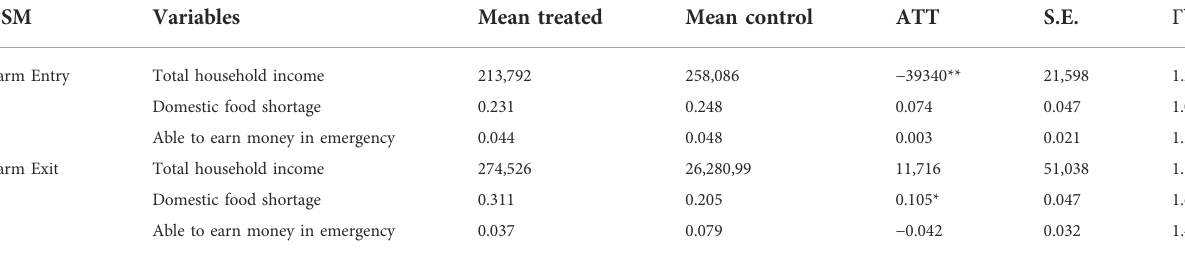
TABLE 10 Average treatment effect on ATTs and critical value of Rosenbaum ’ s Γ by using 1-to-1 matching method. PSM Variables Mean treated Mean control